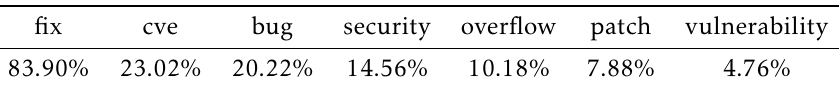
Table 3. The frequency of specific keywords in the vulnerability fix